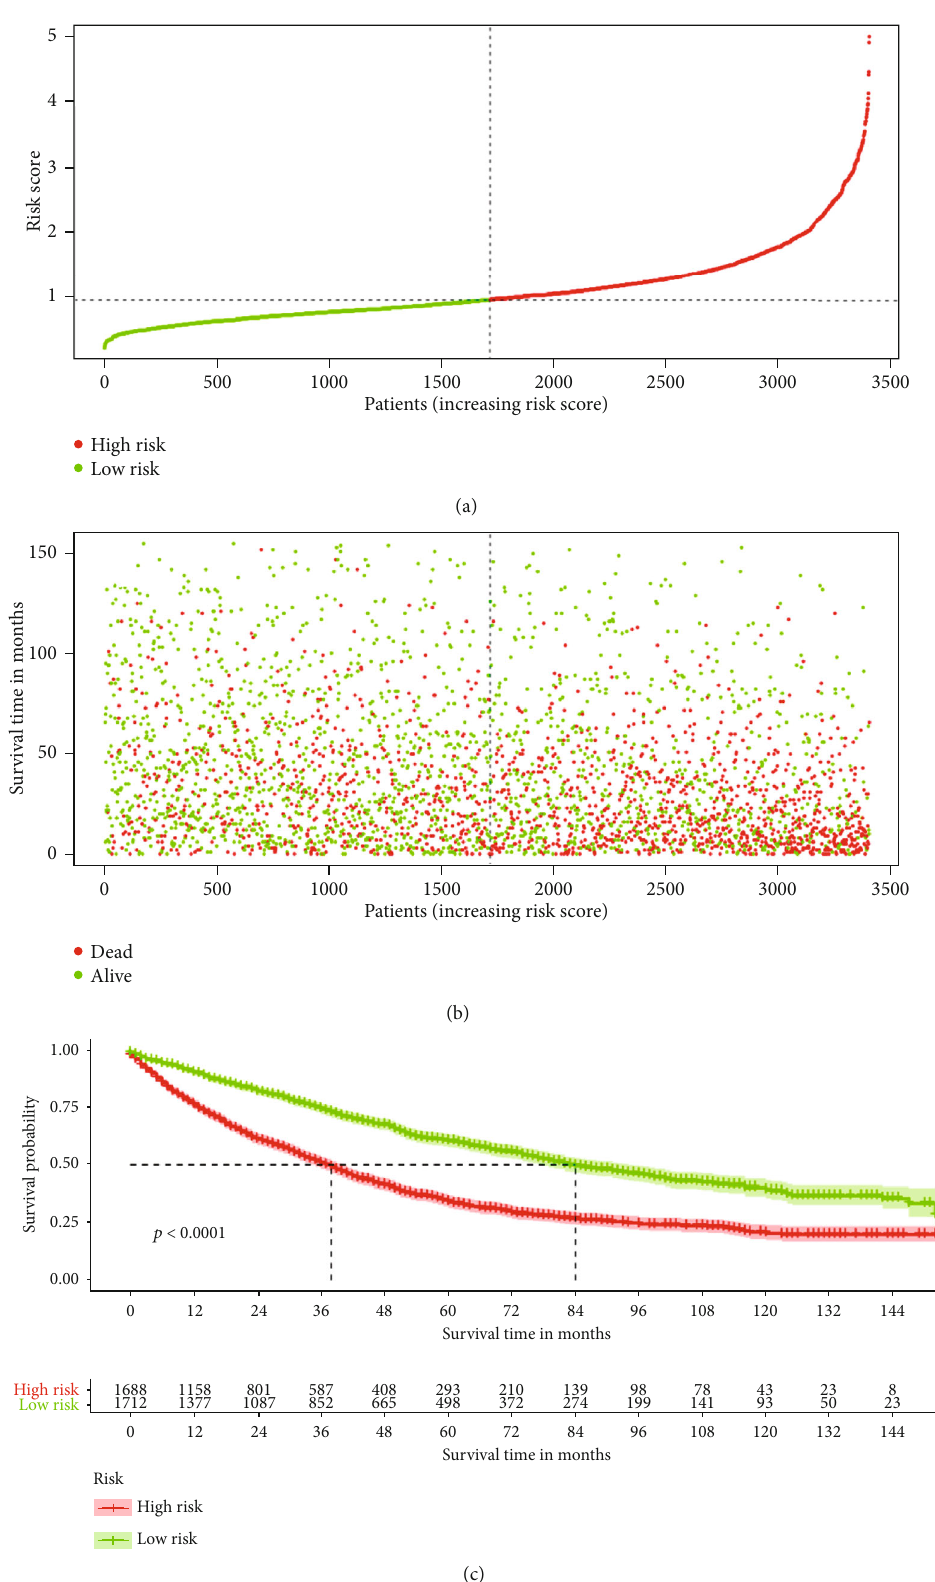
Figure 6: Kaplan-Meier survival curves of HCC patients with high risk scores versus low risk